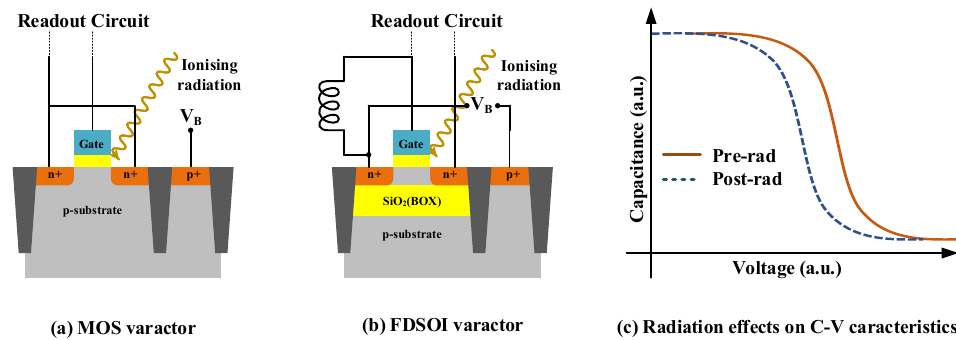
Figure 11. Illustration of ( a ) MOS varactor, ( b ) FDSOI varactor based radiation sensor and ( c ) radiation induced changes in on C-V